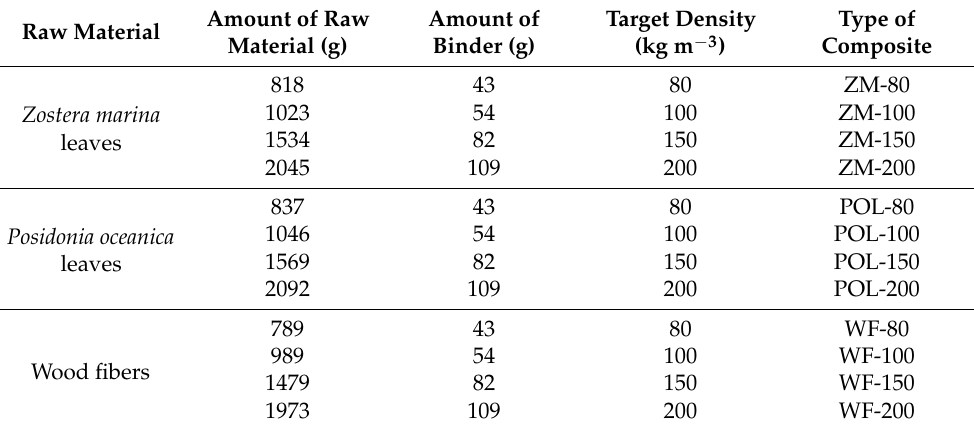
Figure 1. Seagrass boards and the respective raw materials. Boards produced from Zostera marina leaves ( a ), Posidonia oceanica leaves ( b ), and wood fibers ( c ). Table 1. Production variants and the respective abbreviations.